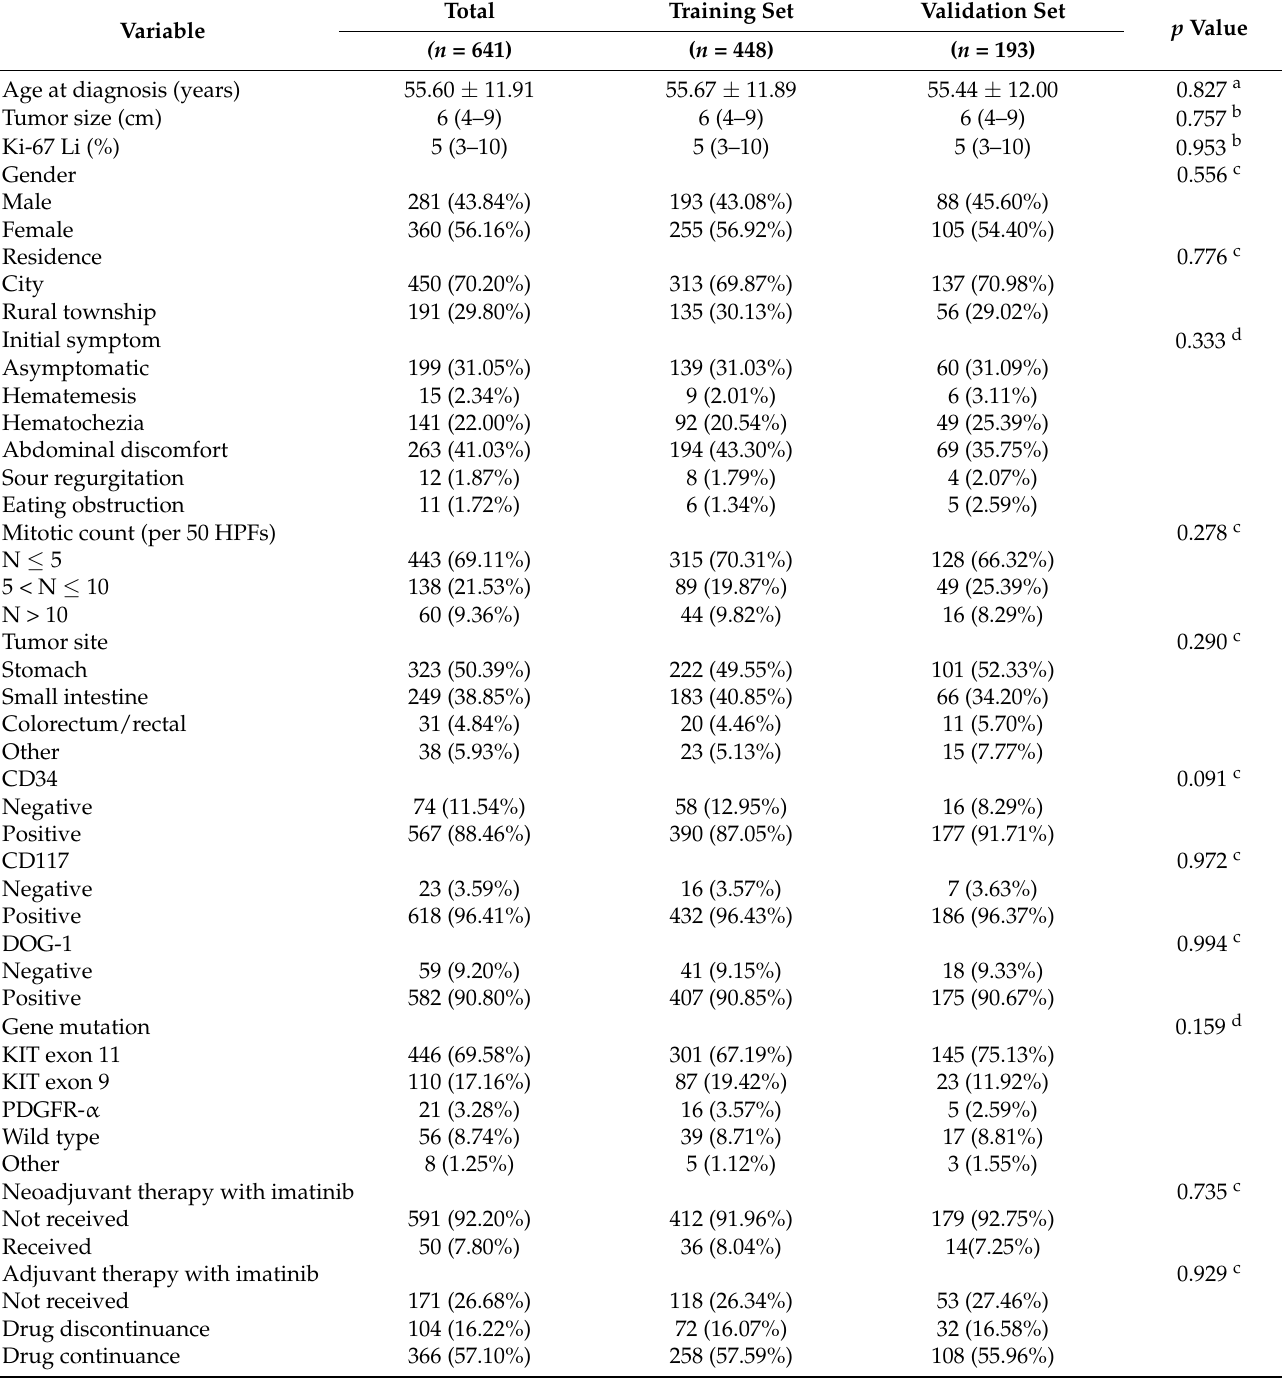
Table 1. Baseline characteristics of GIST patients in the training and validation